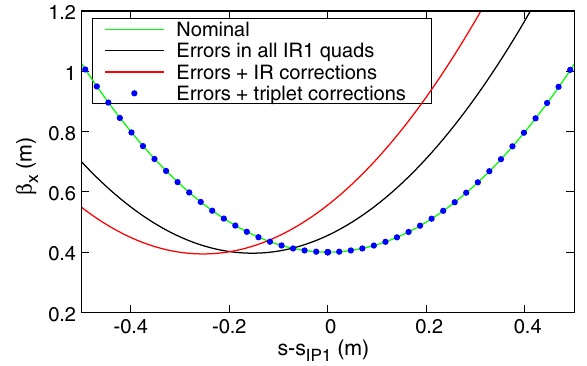
FIG. 9. Simulation of the waist shift of the β (cid:1) due to magnetic errors and corrections. IR corrections increase the waist shift of the β (cid:1) , while triplet-by-triplet corrections eliminate this shift by returning the beta functions to their nominal values. Similar plots are found in the y